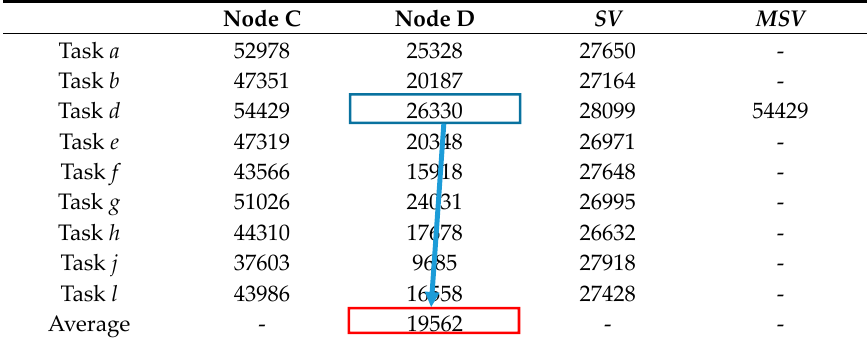
Table 8. Comparison of the average ECT values of tasks in Node D under Case 1.